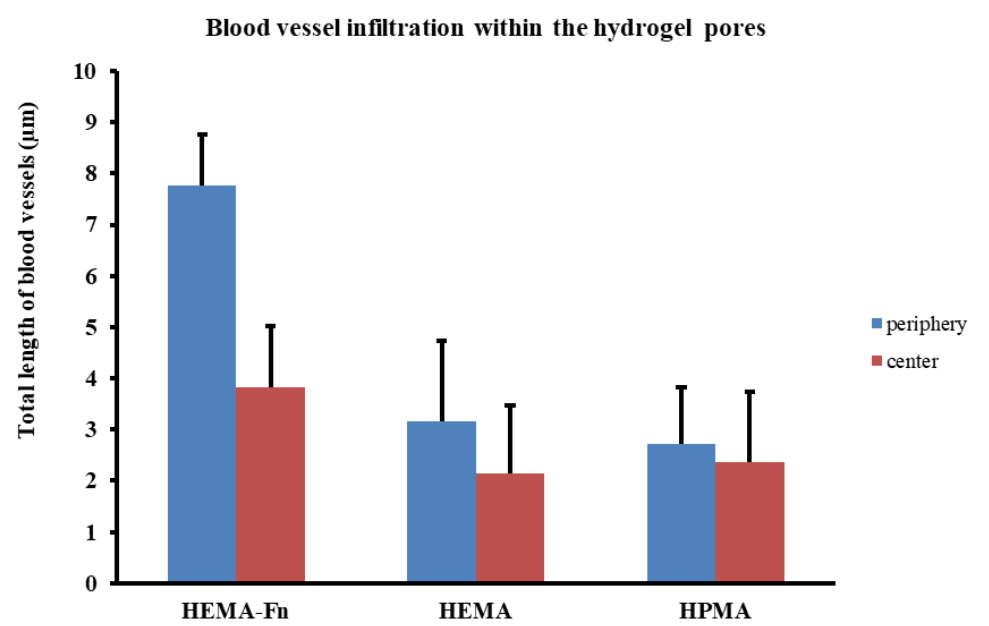
Figure 7. Comparison of blood vessels in growth within the three hydrogels. The total length of blood vessels was assessed within the peripheral (blue bars) as well as the central (red bars) regions of the scaffold. There was no statistically significant difference between the three groups but the HEMA-Fn scaffold showed a trend towards increased ingrowth of blood vessels within its pores, especially in the peripheral areas. Data shown as mean and the error bars represent SEM. For statistical analysis, a one-way ANOVA-test was used.